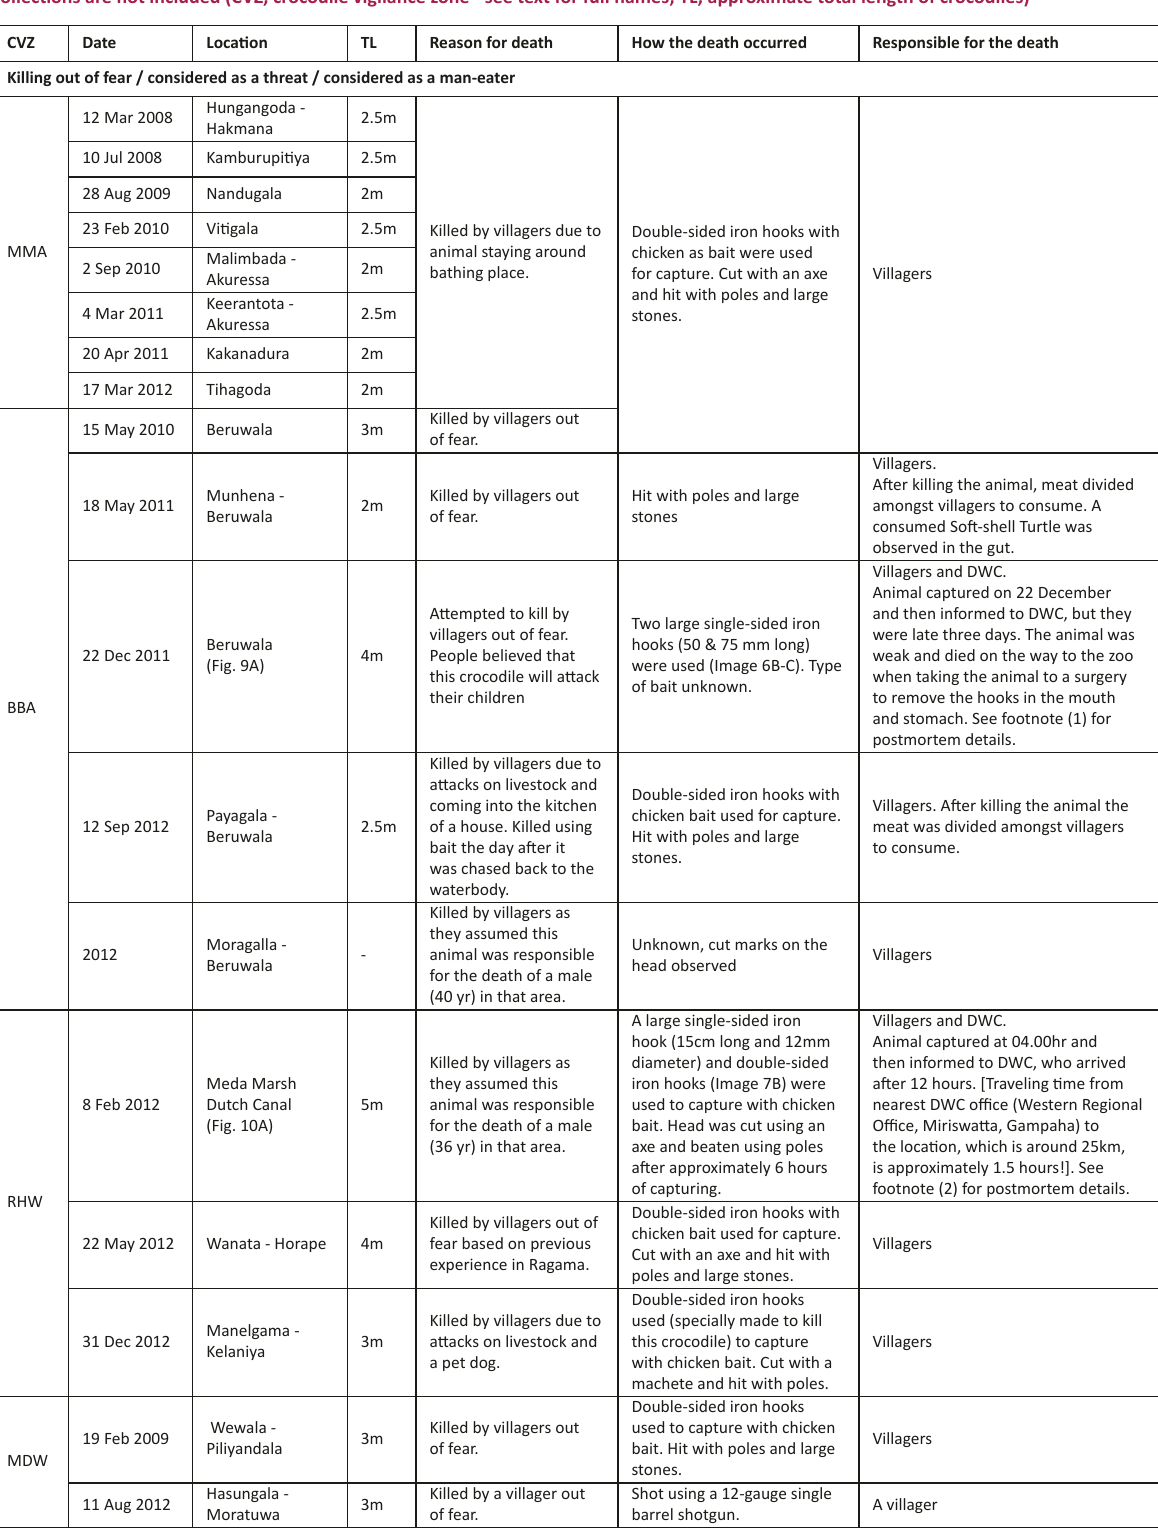
Table 1. Saltwater Crocodile killings, road kills and other human-induced mortality recorded in 2008–2013. Hunting, incidental catch and egg collections are not included (CVZ, crocodile vigilance zone - see text for full names; TL, approximate total length of